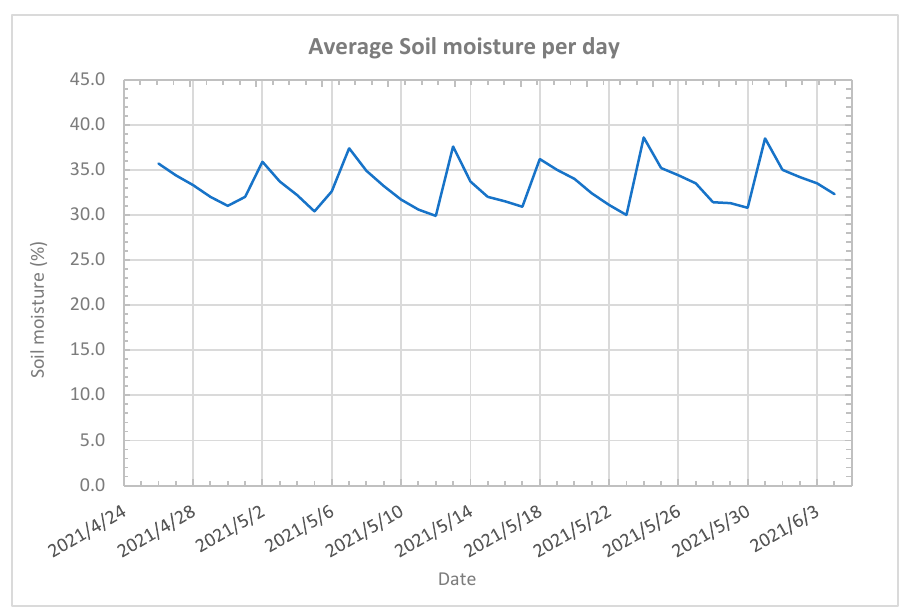
Figure 23. Average soil moisture per day.